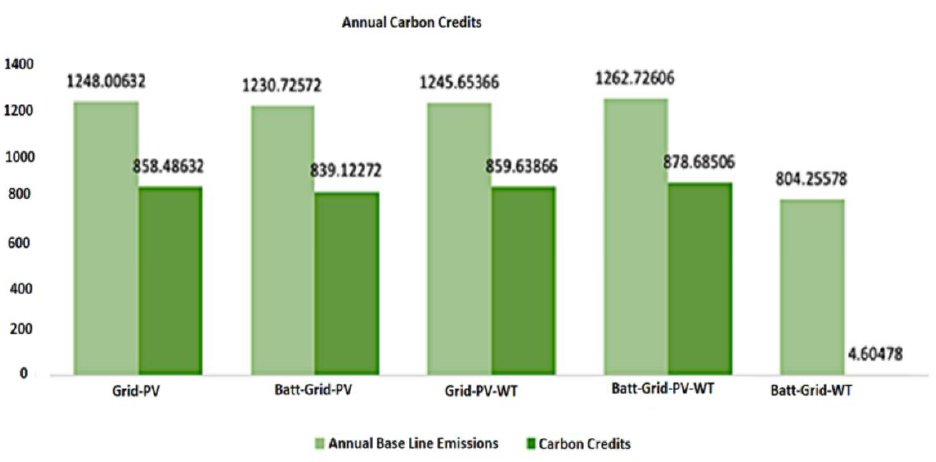
Figure 9. Reduction in carbon dioxide emissions per year.